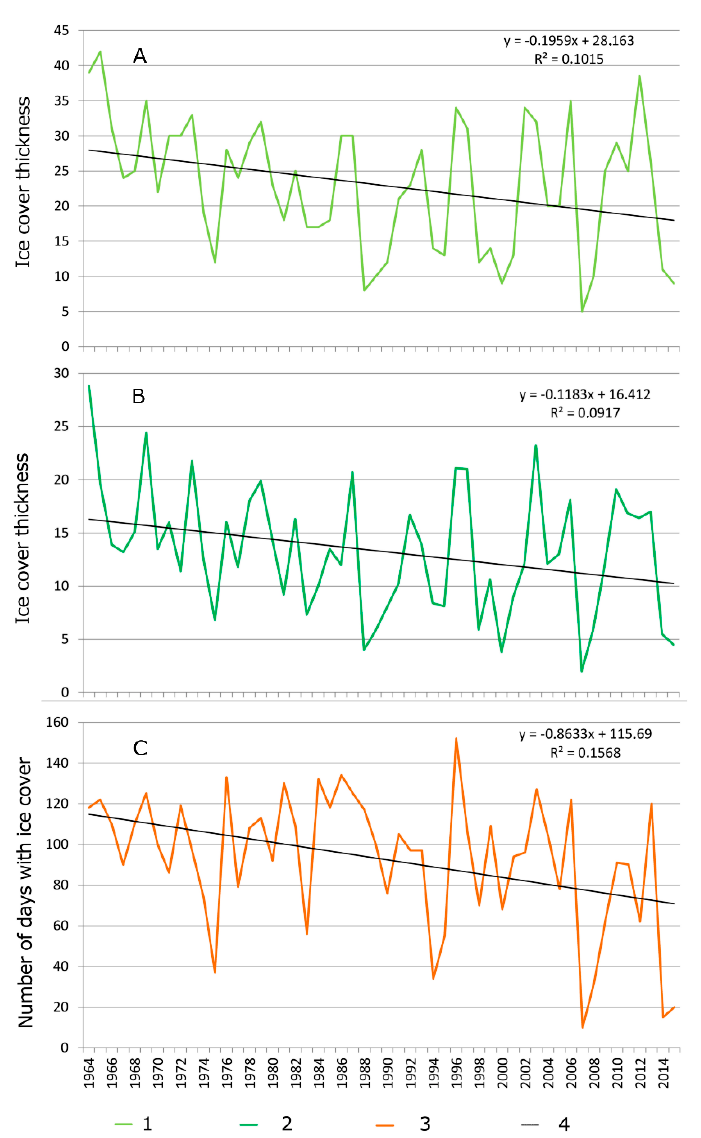
Figure 4. Changes in the maximum ( A ) and average ( B ) ice cover thicknesses and the number of days with ice cover ( C ) for the Koz ł owa Góra reservoir in the period from 1964 to 2015: 1—maximum ice cover thickness (cm), 2—average ice cover thickness (cm), 3—number of days with ice cover (days), 4—trends.